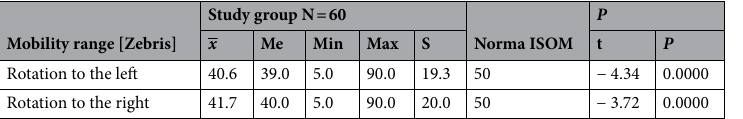
Table 1. Mobility range of cervical spine in study group and its comparison with ISOM norms.